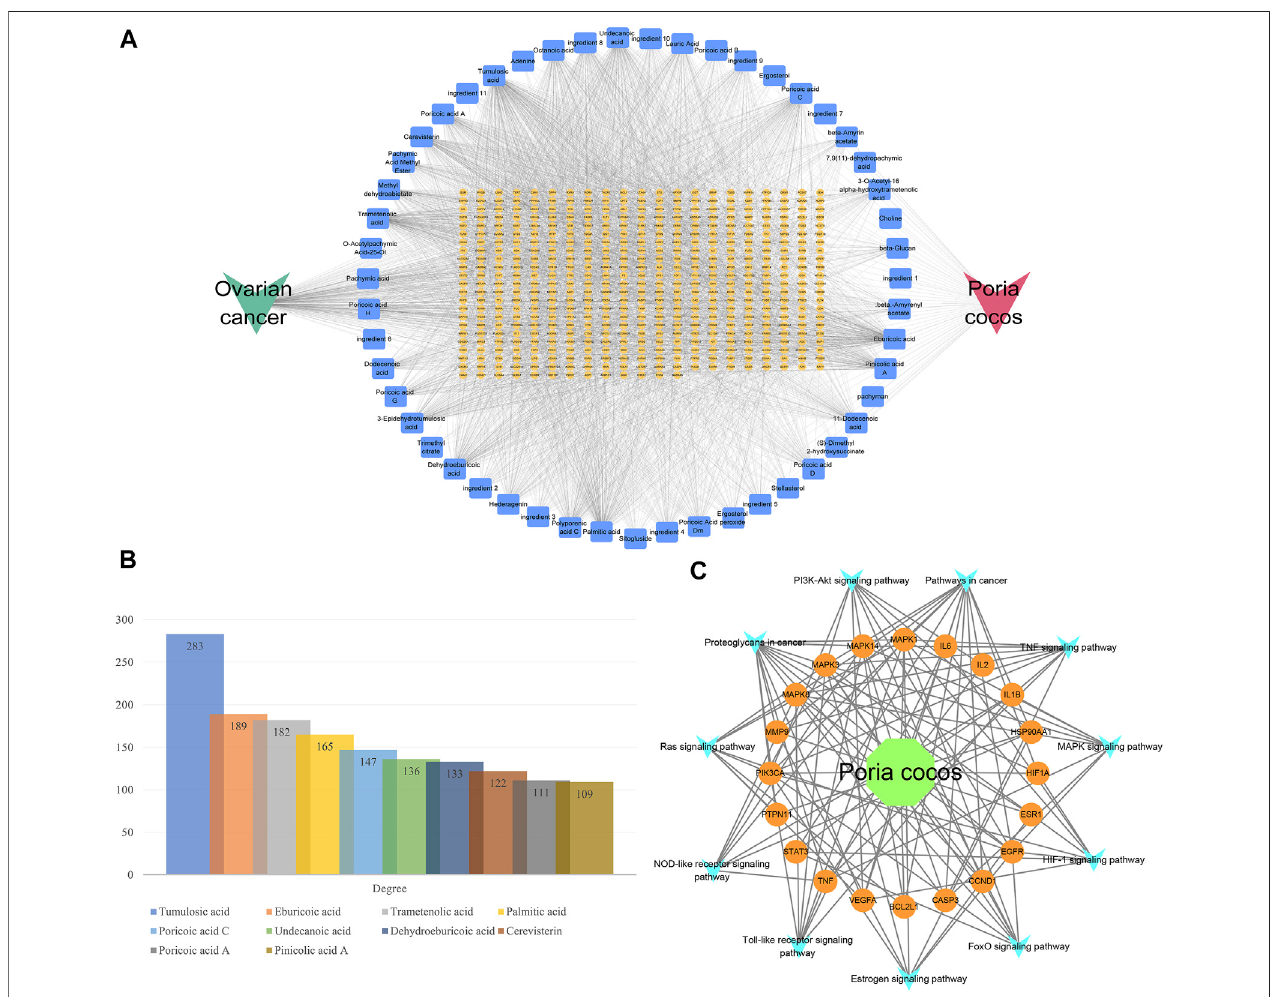
FIGURE 7 | Network construction. (A) The H-I-T-D network. (B) The degree values of important nodes in network. (C) The H-T-P network.